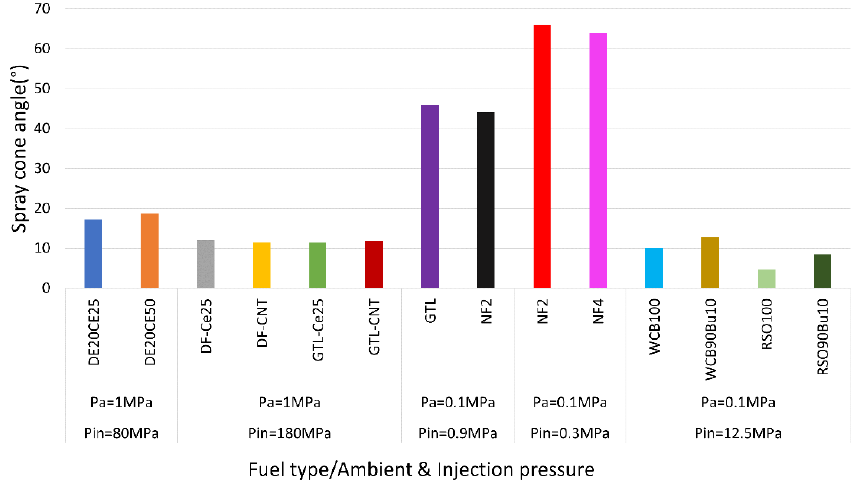
Figure 17. Spray cone angle with nano additives at different injection & ambient pressures [43,122 – 125]. Table 9. Fuel spray characteristics of nano-based